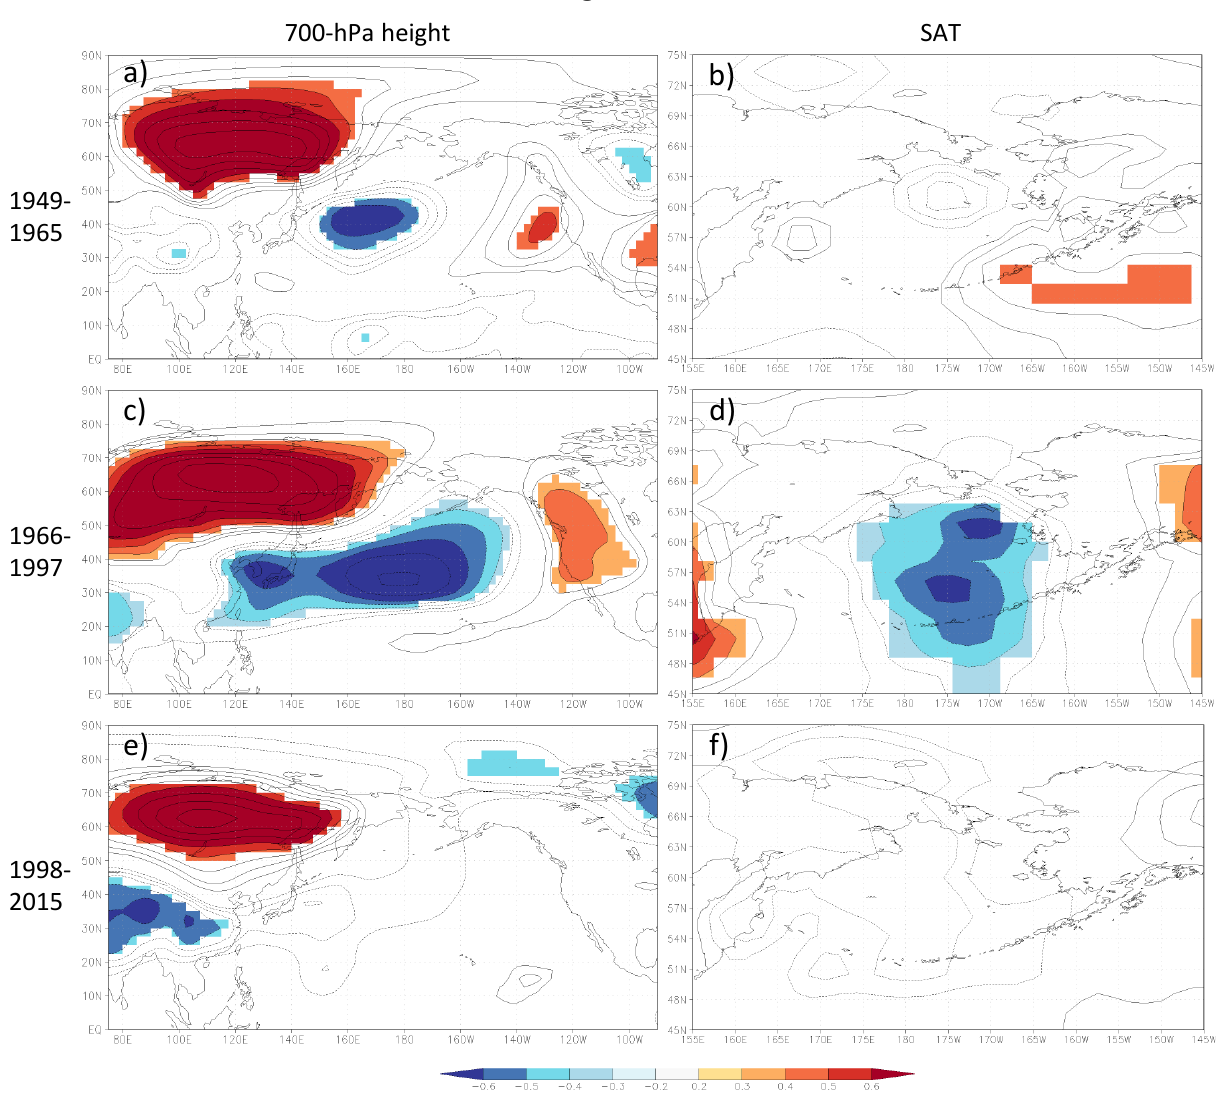
Figure 10. Correlation maps for the Siberian index in the mean winter 700-hPa height ( left column ) and SAT ( right column ) fields for three correlation regimes: (1) ( a , b ) 1949–1965; (2) ( c , d ) 1966–1997; and (3) ( e , f ) 1998–2015. The first differences filter was applied.